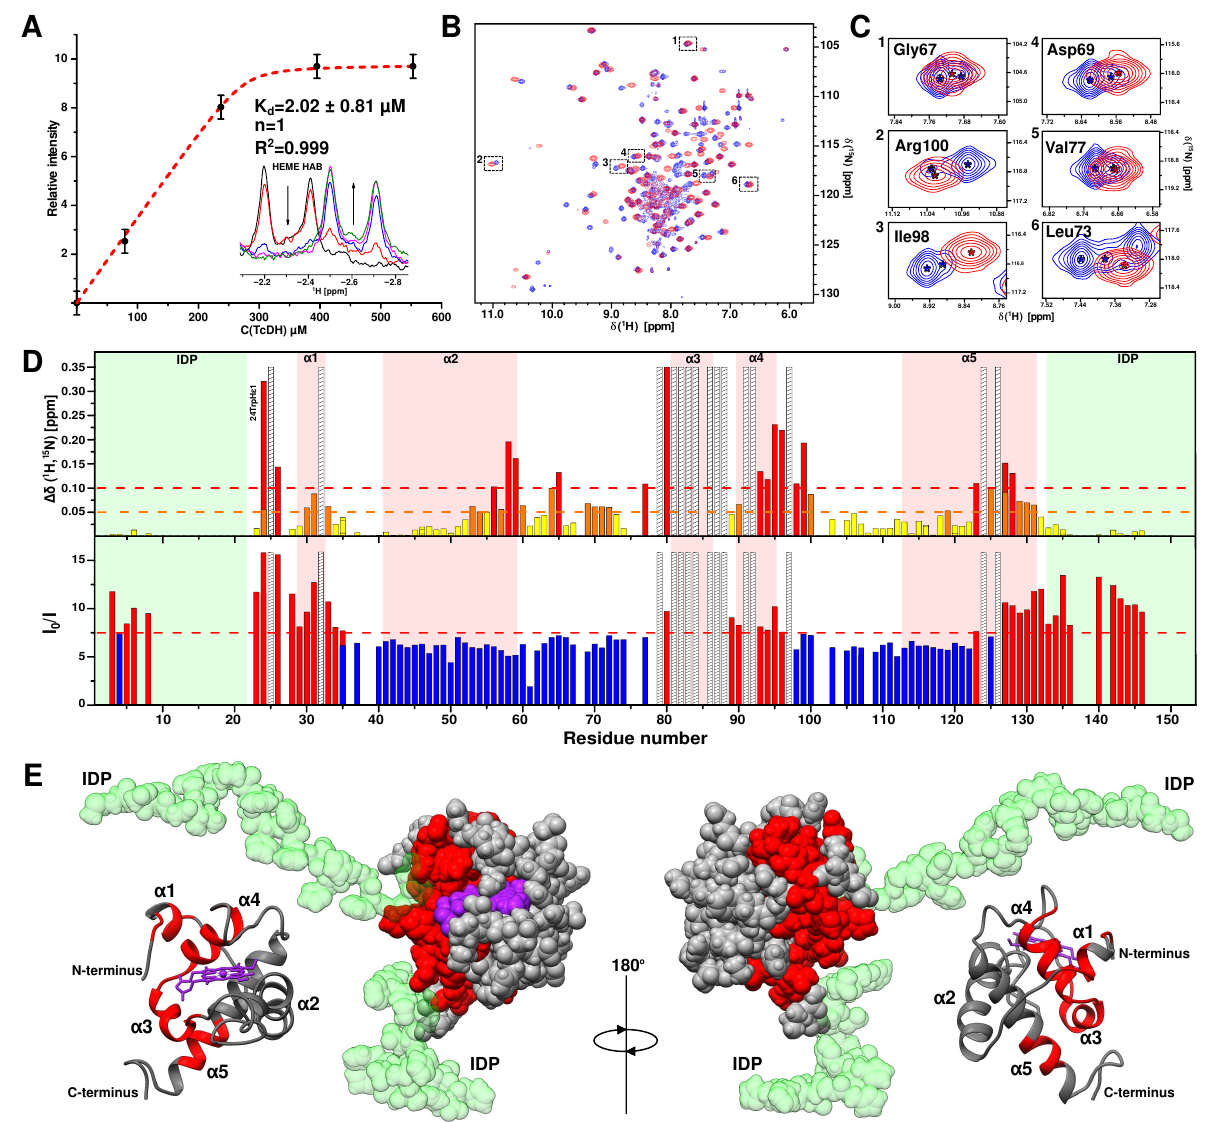
Figure 7. CSP analysis of the interaction of CytC552 with TcDH. ( A ) The dependence of the 1 H- signal intensity of CytC552 heme group HAB atoms on the TcDH concentration. The red dashed line corresponds to the fitting curve. The inset shows the corresponding region of superimposed 1 H spectra. ( B ) Overall 1 H/ 15 N-HSQC spectra of free CytC552 (blue) and bound to TcDH (red). ( C ) Selected regions of 1 H/ 15 N-HSQC spectra with cross-peaks with and without signal splitting for free CytC552 (blue) and bound to TcDH (red), respectively. ( D ) Histogram of generalized 1 H/ 15 N- chemical shifts changes for amide groups (top) and change of its cross-peaks intensity relative to unbound state of CytC552 (bottom). The residues, whose cross-peaks undergo either strong displacements (shifts) or broadenings beyond the detection range are shaded. The red dashed line corresponds to the standard deviation (SD) of the chemical shift changes and orange dashed line corresponds to the half of standard deviation (SD/2). The bars with values above the standard deviation are colored in red, in the range between SD/2 and SD are colored in orange, and below SD/2 are colored in yellow. On the graph of the cross-peaks intensity change (I 0 /I), the red dashed line corresponds to the average value (AV). The bars above the AV are colored in red and below are colored in blue. ( E ) Different types of CytC552 structure presentations colored according to the results of CSP analysis: the residues with highest CSP are highlighted in red; the N- and C-terminal IDP tails are colored in